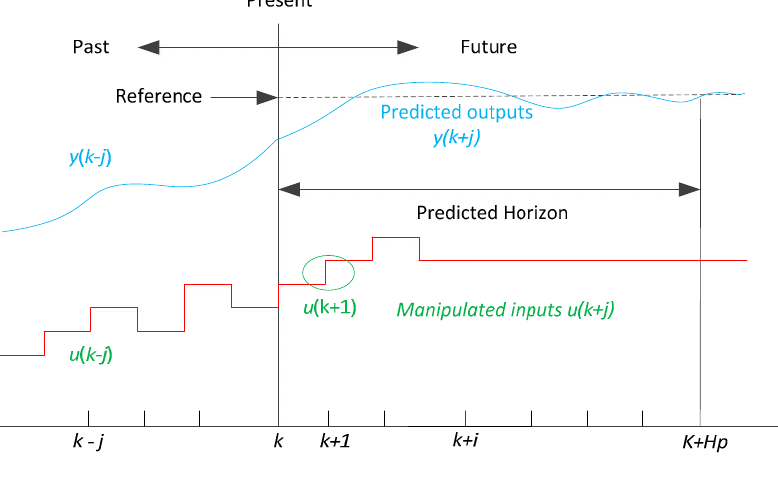
Figure 2. Receding horizon principle of MPC [23].